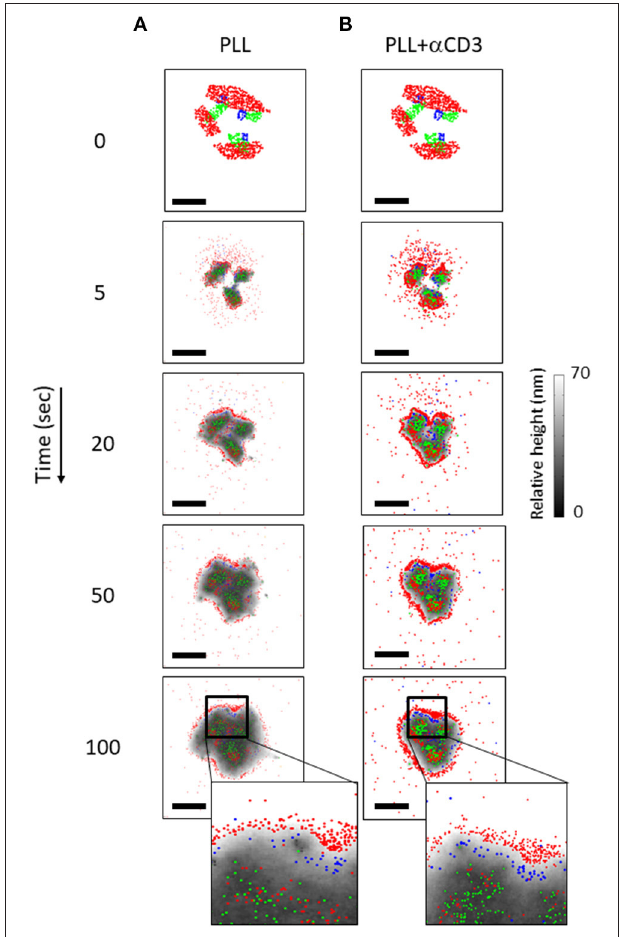
FIGURE 7 | The dynamics of molecular patterning in simulations. The dynamic evolution of molecular patterning of TCRs (green), CD11 (blue) and CD45 (red) at the cell interface. Simulated results are shown as a function of time for individual cells on either a PLL–coated coverslip (A) or on an α CD3-coated coverslip (B) along time. The simulations start from user-defined initial conditions (top raw) that are set for the simulated molecules. Membrane height is marked by variable gray levels. Bars − 1 µ